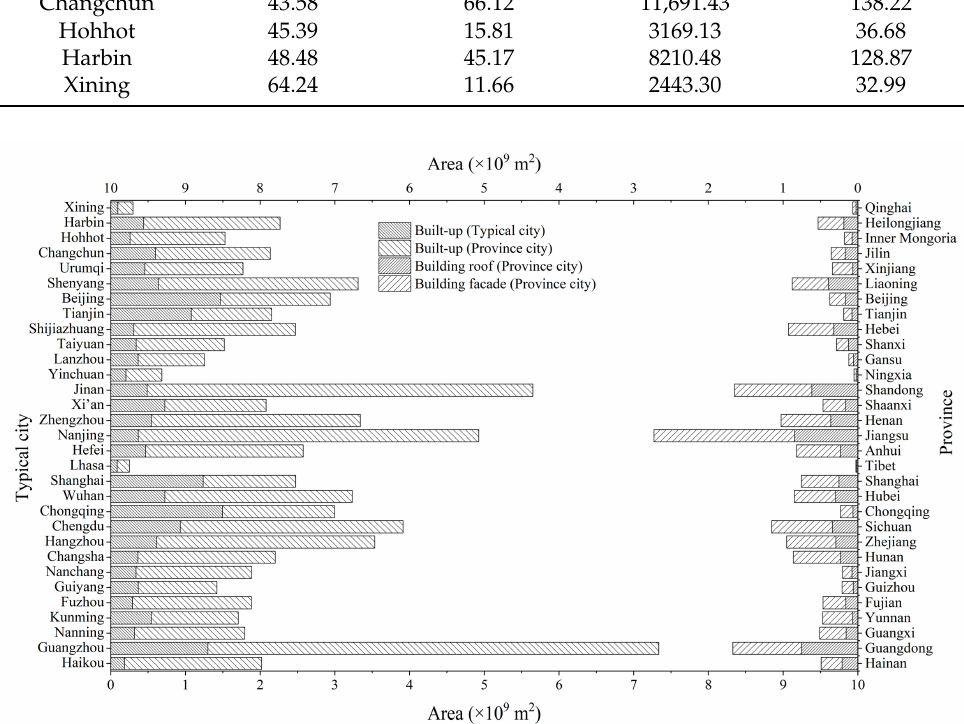
Figure 5. Construction area of each